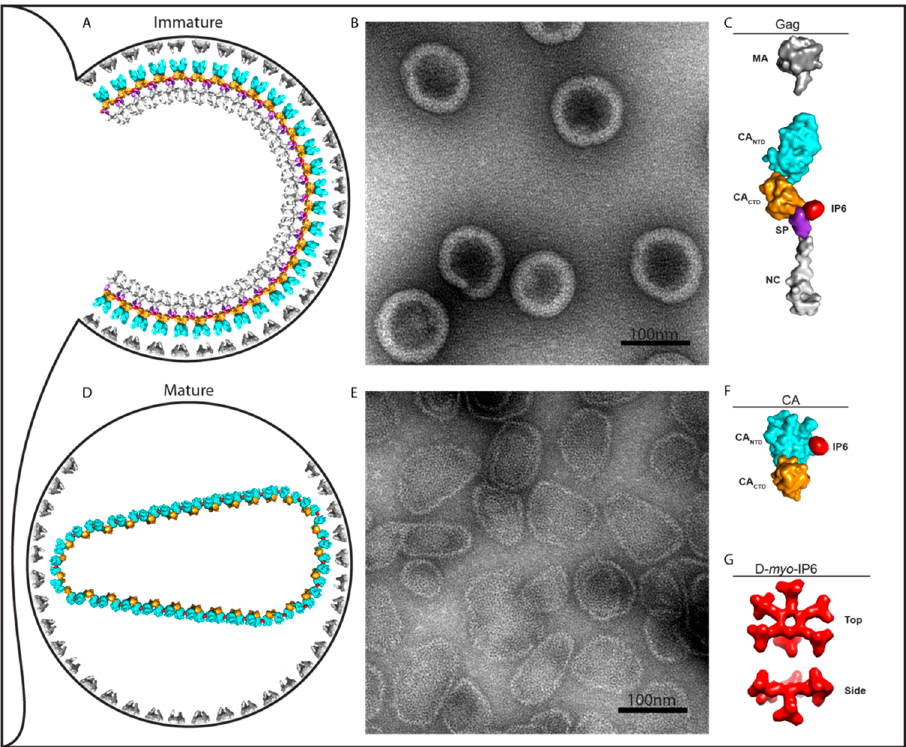
Figure 1. Role of IP6 on immature and mature assembly. ( A ) Drawing of an immature virus particle budding from cellular plasma membrane. ( B ) Negative stain EM image of immature-like virus particles assembled in vitro with IP6. ( C ) Depiction of Gag molecule from ( A ) showing IP6 bound at the interface of CA CTD and SP. ( D ) Drawing of a mature virus particle. Following cleavage of Gag, IP6 promotes the formation of the mature lattice by CA. ( E ) Negative stain EM image of IP6-induced assembly of HIV-1 CA protein into mature-like virus particles. ( F ) Depiction of CA molecule from ( D ) with IP6 bound. ( G ) Top and side-view of IP6 d -myo-IP6, the most abundant isoform, with one axial and five equatorial phosphates. Note that in diagrams A and C, the viral envelope proteins and the RNA genome and associated proteins are not shown.